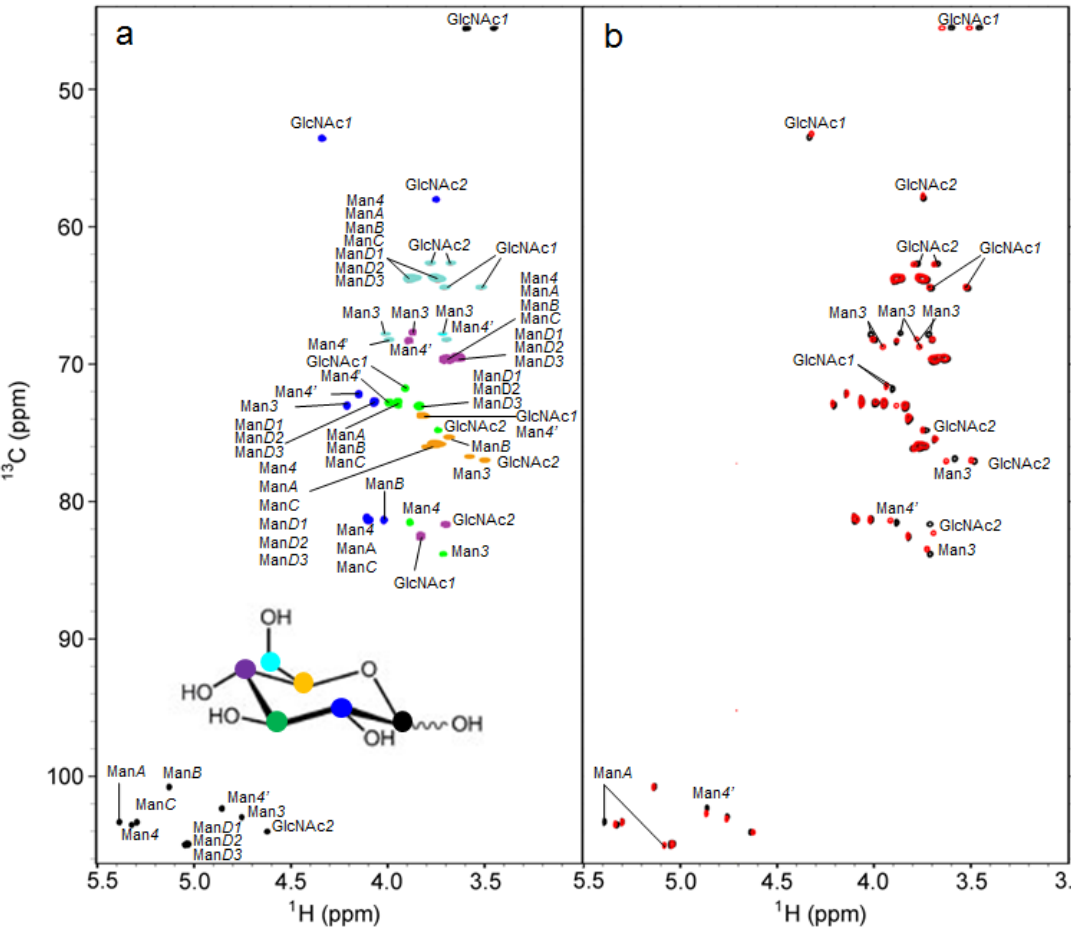
Figure 3. (a) 1 H- 13 C Heteronuclear Single Quantum Coherence (HSQC) spectra of the PA derivative of M9, metabolically 13 C-labeled with D-[1- 13 C]glucose ( black ), D-[2- 13 C]glucose ( blue ), D-[3- 13 C]glucose ( green ), D-[4- 13 C]glucose ( magenta ), D-[5- 13 C]glucose ( orange ) or D-[6- 13 C]glucose ( cyan ). The six spectra were superposed and the 13 C-labeled positions in the glucose isotopomers used as metabolic precursors are shown with circles in the same colors as the corresponding spectra. 1 H- 13 C HSQC experiments were performed at a proton observation frequency of 920.7 MHz with 256 ( t ) × 1024 ( t ) complex points and 16 scans 1 2 per t increment. The spectrum widths were 15.1 kHz for the 13 C dimension and 5.8 kHz 1 for the 1 H dimension. (b) 1 H- 13 C HSQC spectra of the PA derivative of M9 ( black ) and Man  1-2Man  1-6(Man  1-3)Man  1-6(Man  1-2Man  1-2Man  1-3)Man  1-4GlcNAc  1- 4GlcNAc glycoform (M8B) ( red ) uniformly labeled with 13